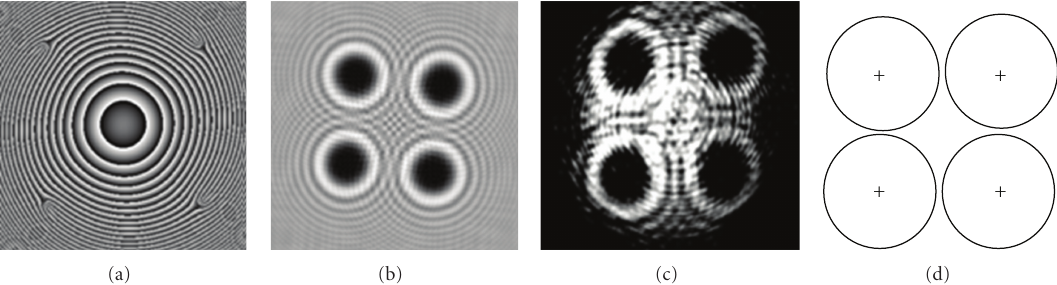
Figure 3: Fresnel lens with four vortices, each of topological charge 2 embedded at o ff -axis locations. (a) Phase distribution displayed on SLM. (b) Simulated intensity distribution near the focal plane. (c) Experimentally observed intensity distribution near the focal plane. (d) Distribution of topological charge in the intensity pattern.